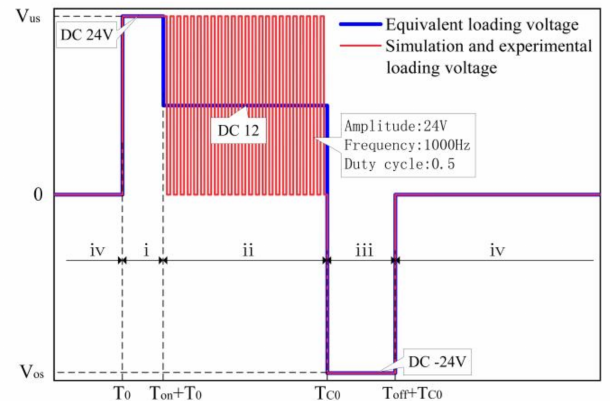
Figure 10. Equivalent voltage of control signals in the simulation and experiment.